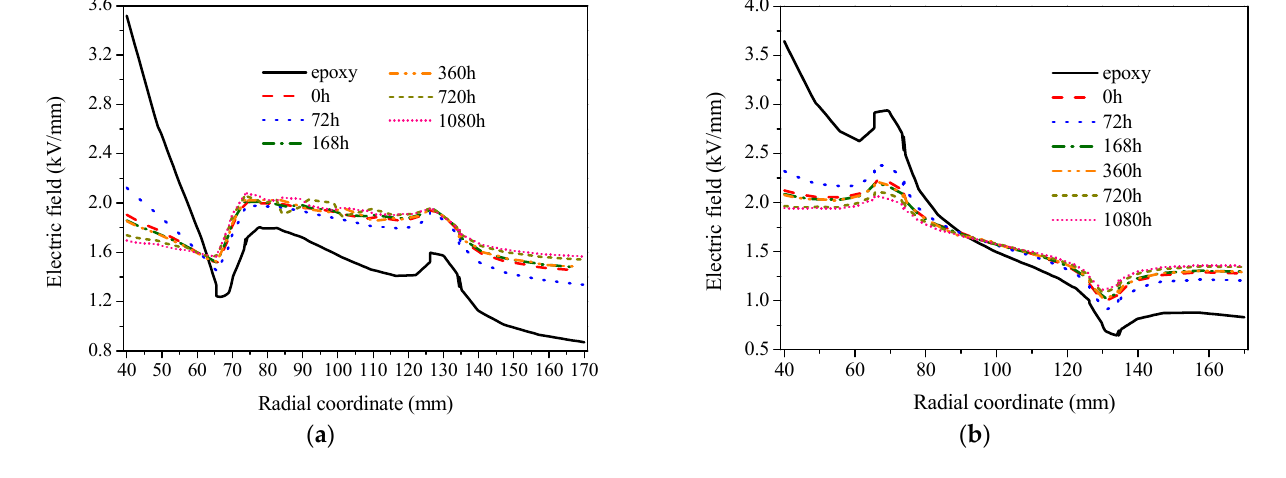
( b ) Figure 8. Power dissipation density in the cone spacer with pure epoxy or aged SiC/epoxy mi-cro- composites: ( a ) pure epoxy; ( b ) 1080 h-aged SiC/epoxy micro-composites. Figure 9 illustrates the power dissipation density profiles along the upper and lower surfaces of spacer with pure epoxy and aged SiC/epoxy micro-composite, respectively. It can be observed that the relationship between the power dissipation density and ageing time of the spacer’s upper surface is similar to that of spacer’s lower surface. Moreover,